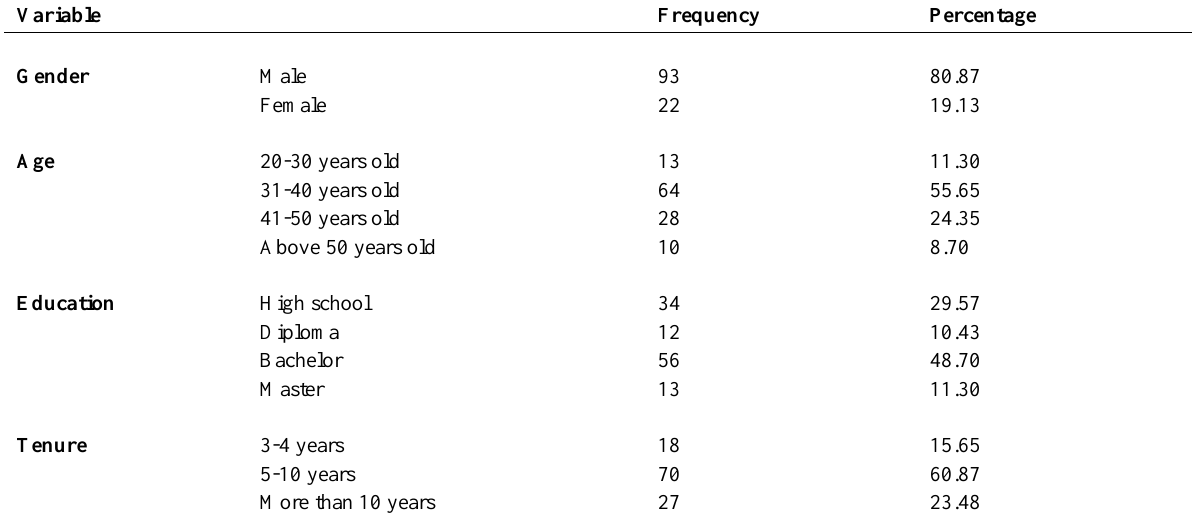
Table 1: Demographic Profile of